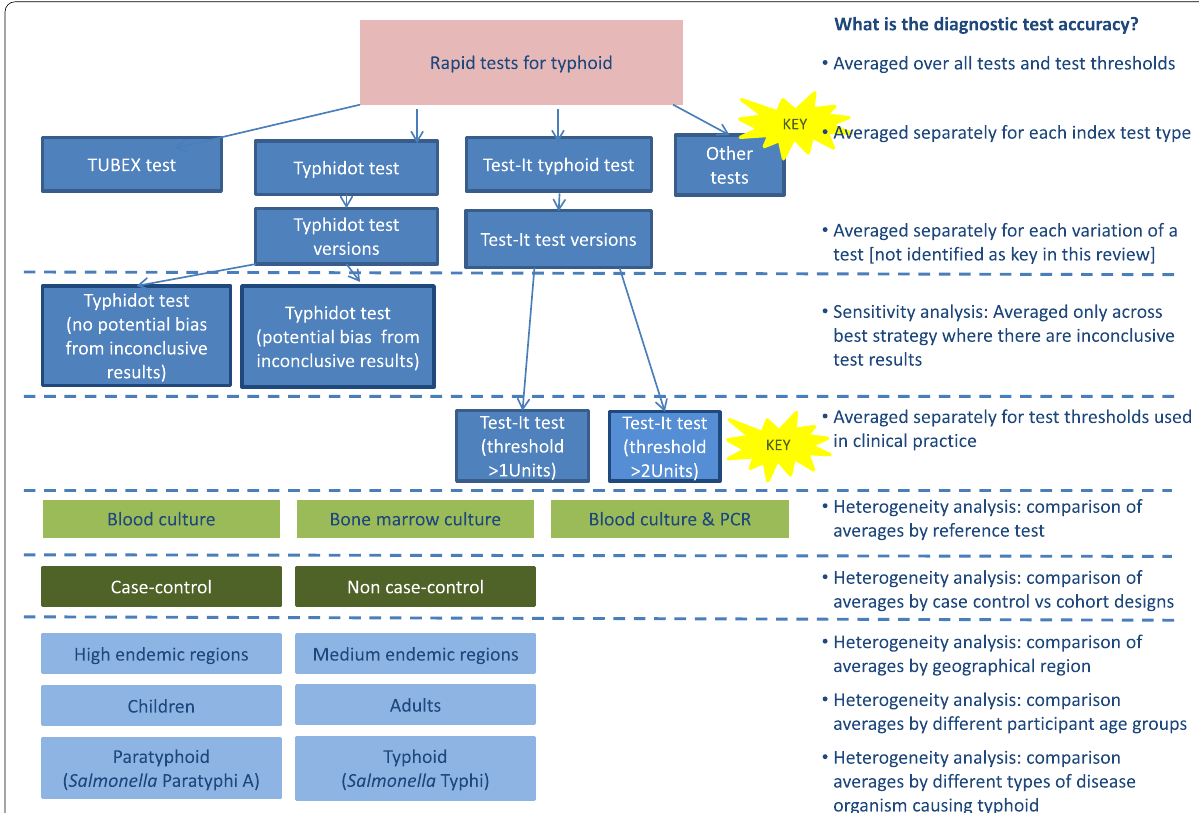
Fig. 1 Flowchart of planned analyses: Typhoid review. Different components of variation leading to complexity in review of typhoid rapid tests. Coloured boxes indicate the TOMAS-R domain where complexity identified: pink boxes review topic; light blue boxes participant domain; dark blue boxes index test domain; light green boxes target condition domain; dark green boxes study design and quality domain. Dotted lines separate complexity and allow alignment to the diagnostic accuracy that the analysis would address. Each bullet point follows the question “What is the diagnostic accuracy...” so for example if all rapid test results are combined the first bullet point is used so the analysis will answer the question “What is the diagnostic accuracy averaged over all tests and test thresholds ?” Yellow stars indicate key complexities identified as requiring separate